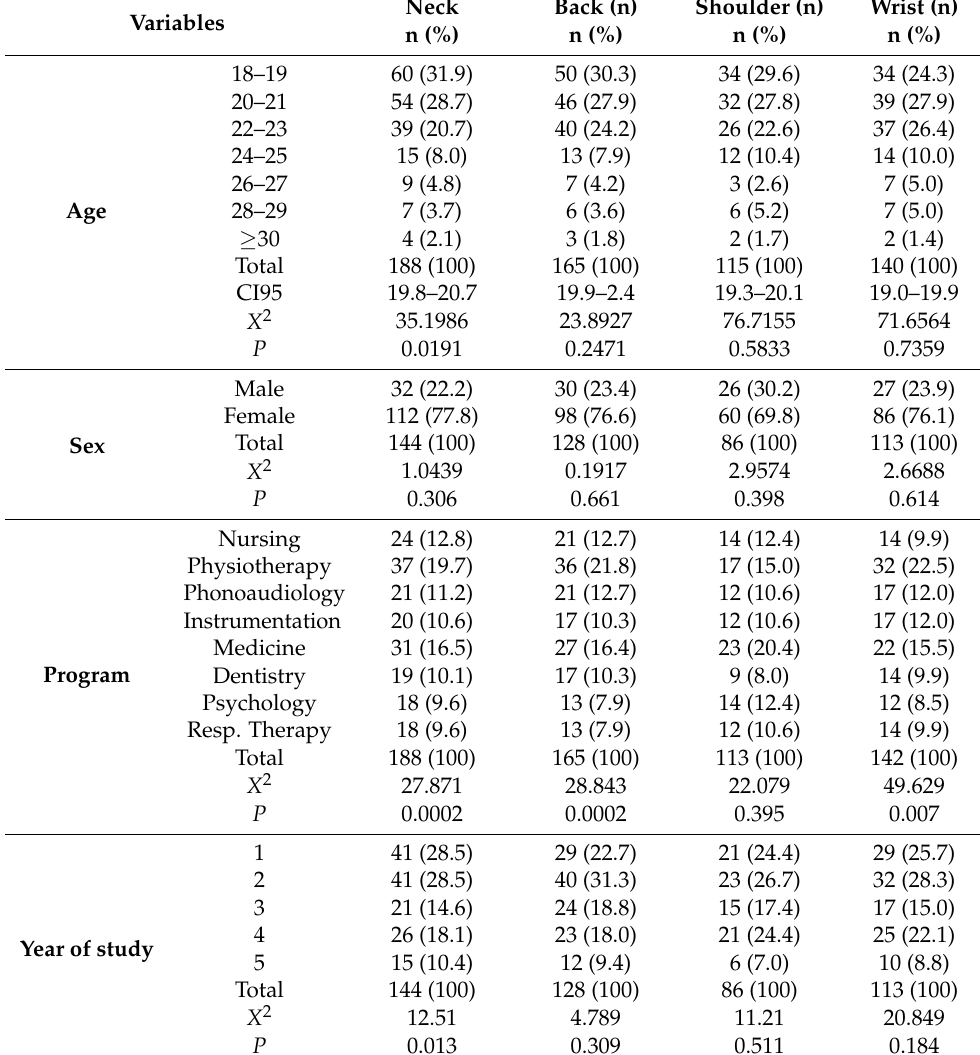
Table 1. Sociodemographic characteristics, dependency and MSSs.